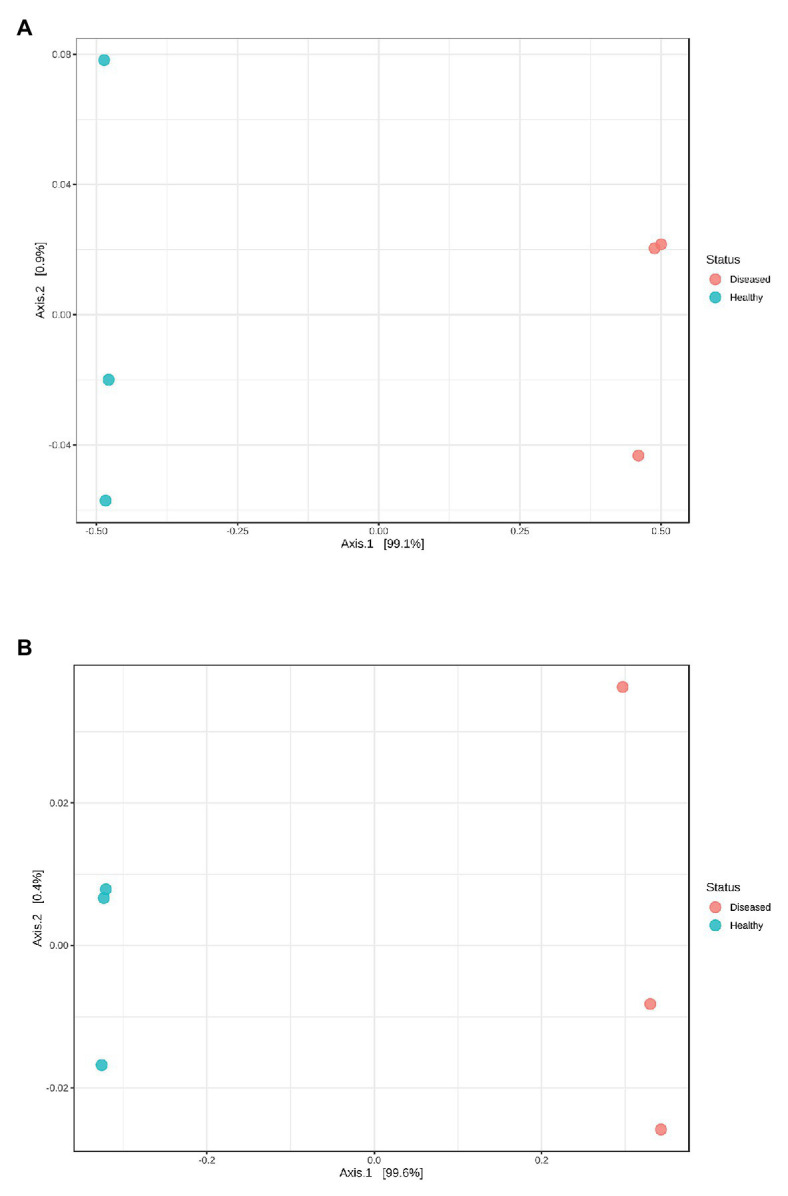
Principal coordinate analysis plots based on (A) Bray Curtis index and (B) weighted UniFrac distance methods showing similarity in pereiopod sequence libraries of P. ornatus phyllosomas.